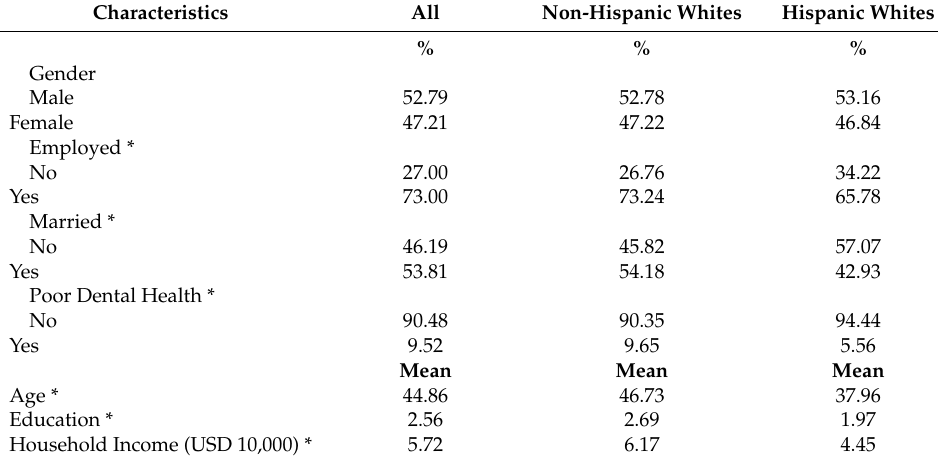
Table 1. Descriptive statistics in the pooled sample and based on